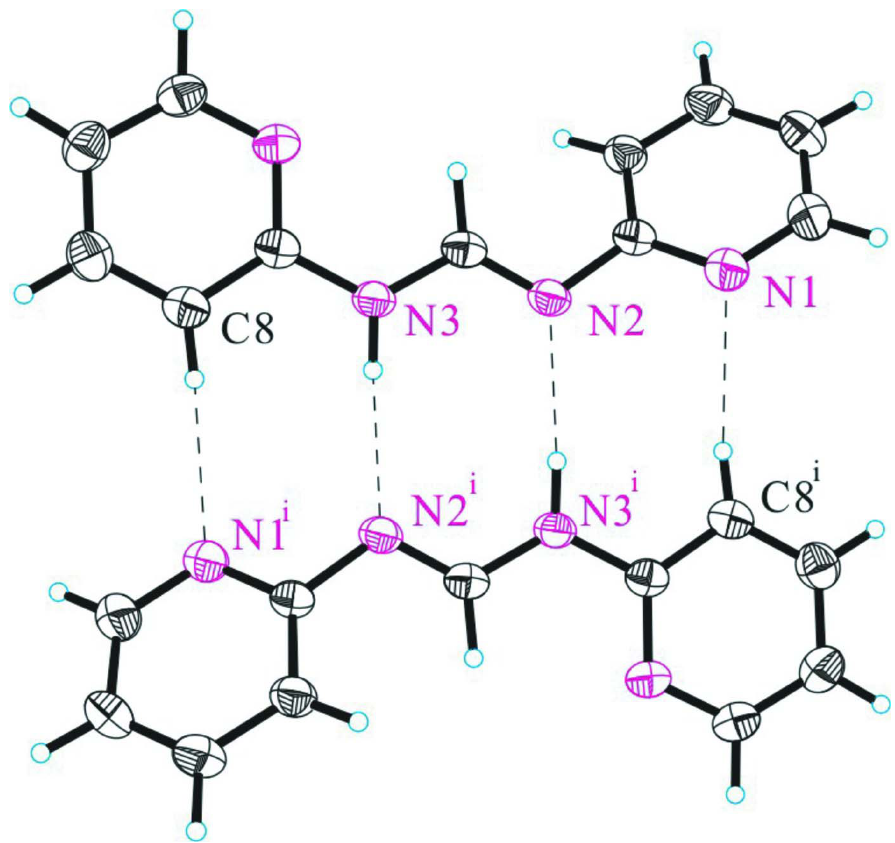
Figure 2 View onto the dimers formed by intermolecular hydrogen bonding, which is shown as dashed lines. Symmetry code: (i) - x+1, -y,